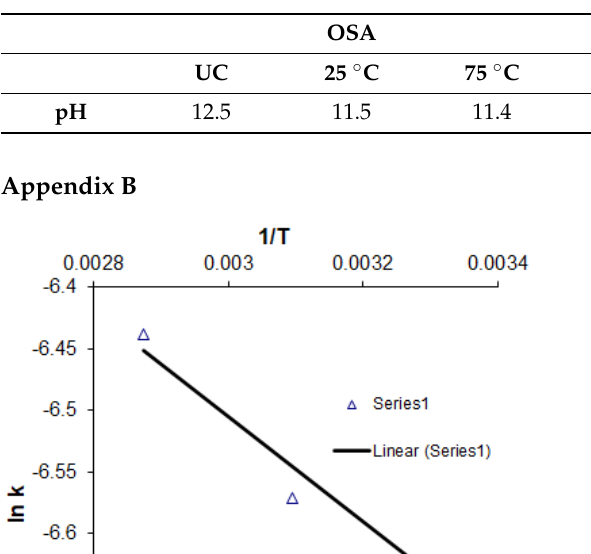
Table A1. pH measurements of compacts (UC: Uncarbonated, 25 ◦ C: Carbonated at 25 ◦ C, 75 ◦ C: